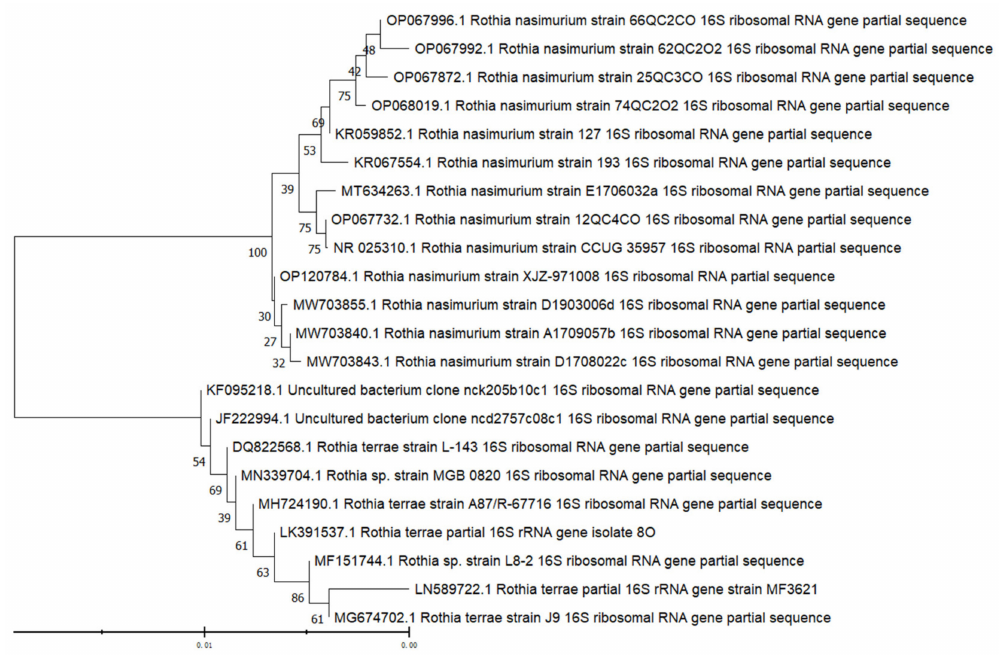
Figure 4. Phylogenetic tree based on bacterial 16S rRNA genes. Lane M: DL-2000 marker; Lane 1: negative control; Lanes 2–5: 16S rRNA amplification results of isolated